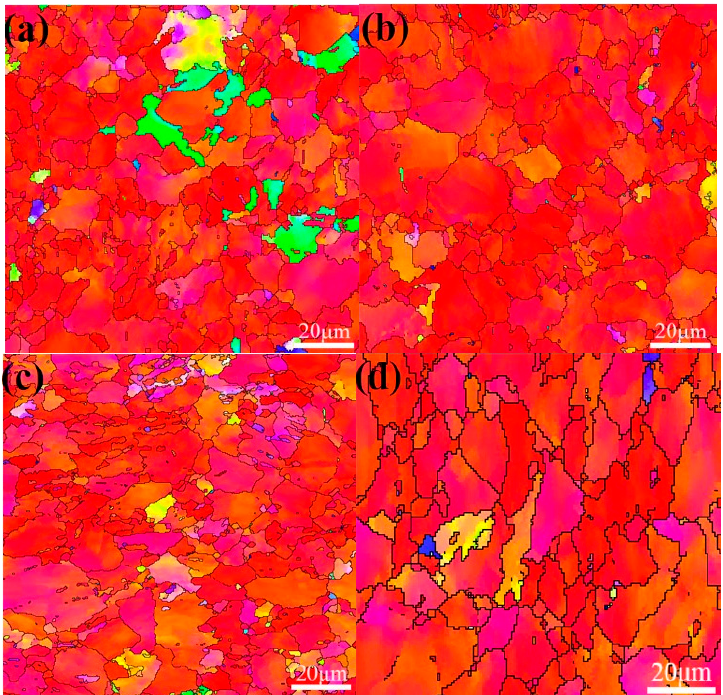
Figure 3 . The microstructure of the rolled AZ80 magnesium alloy pre-aged for: ( a ) 75; ( b ) 160; ( c ) 200 and ( d ) 240 min.